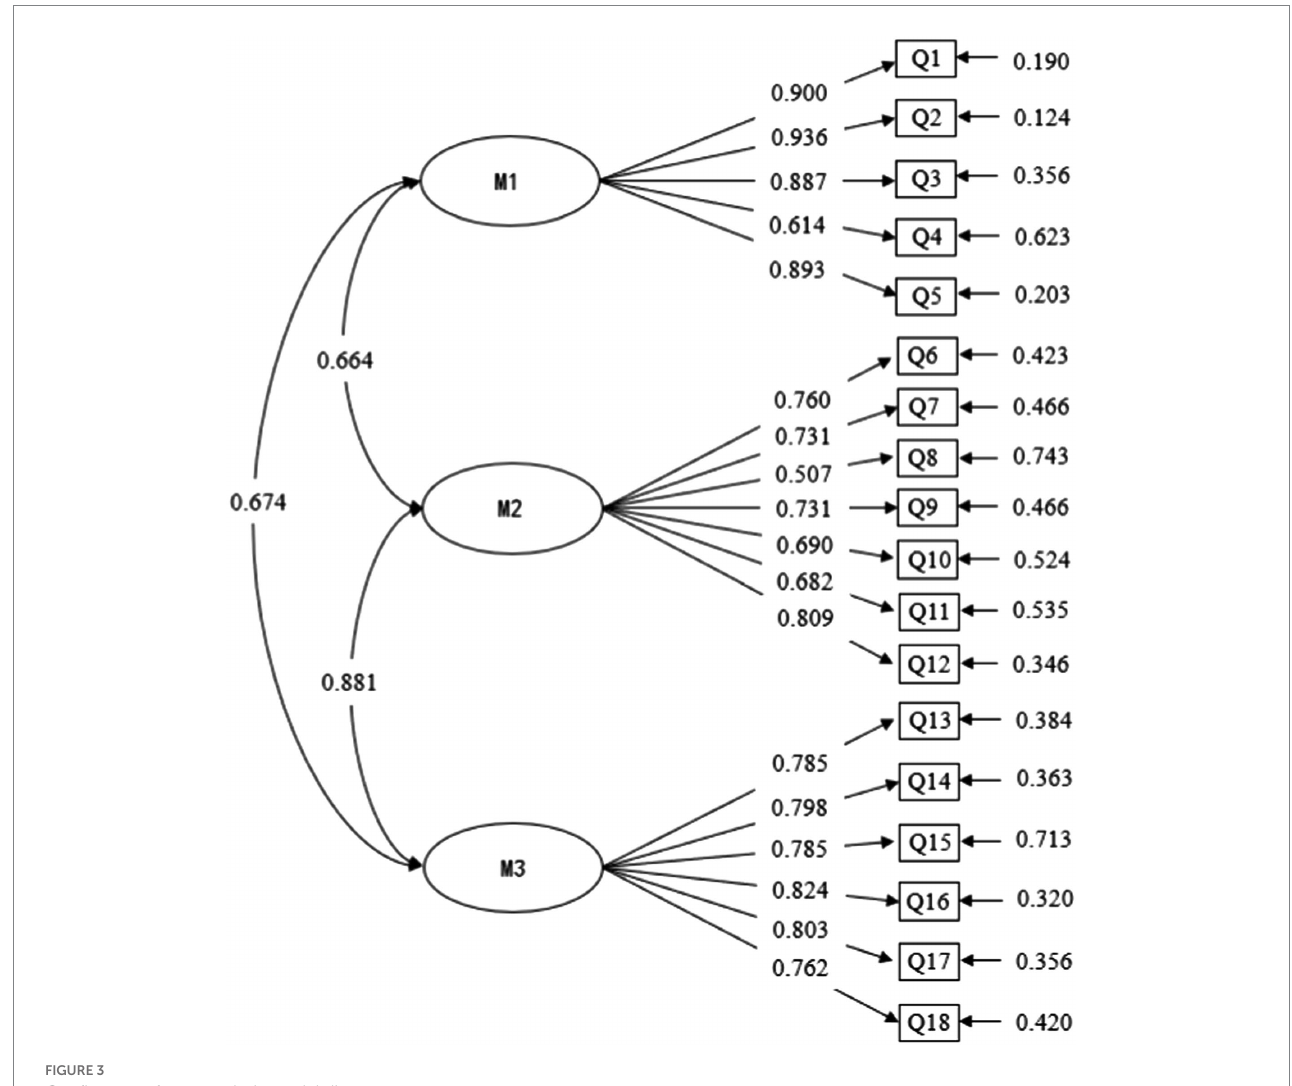
FIGURE 3 Confirmatory factor analysis model diagram.